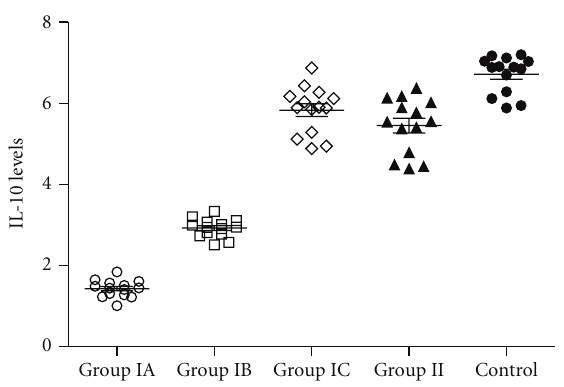
Figure 2: Serum IL-10 levels of all study groups. The numbers of samples of the all groups are 14 for each. Group IA: severe persistent asthma patients before the treatment. Group IB: 4 months after the anti-IgE therapy, severe persistent asthma patients. Group IC: 18 months after the anti-IgE therapy, severe persistent asthma patients. Group II: newly diagnosed controlled allergic asthma patients.